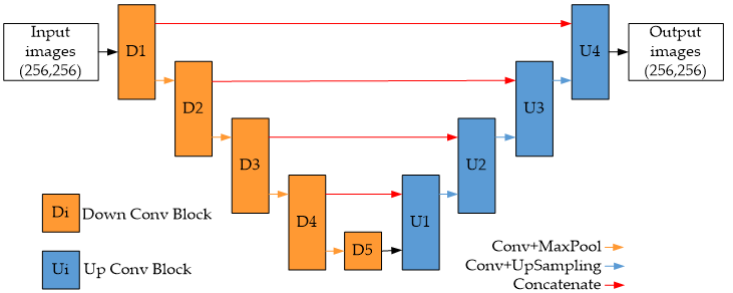
Figure 5. The U-Net